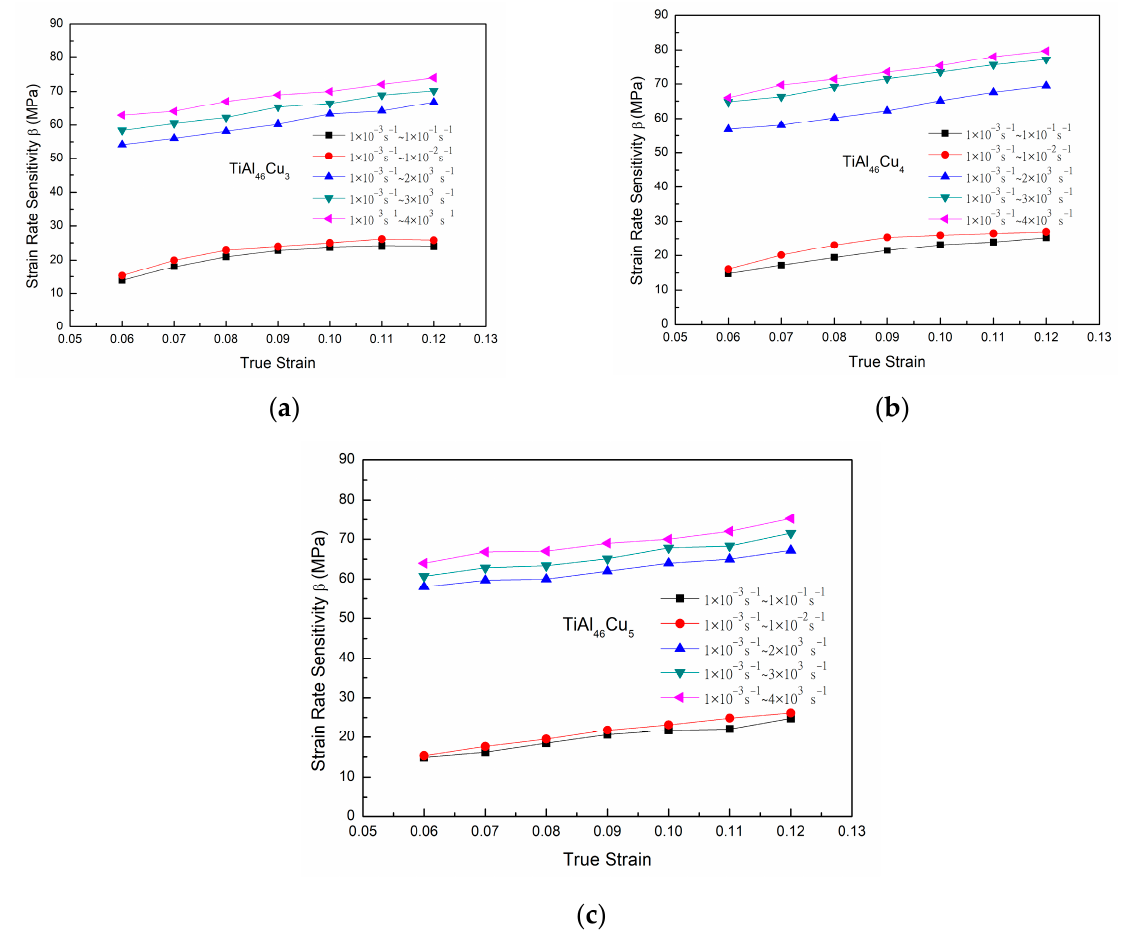
Figure 4. Strain rate sensitivity of TiAl 46 Cu x specimens under dynamic strain rates: ( a ) TiAl 46 Cu 3 ; ( b ) TiAl 46 Cu 4 ; and ( c ) TiAl 46 Cu 5 .